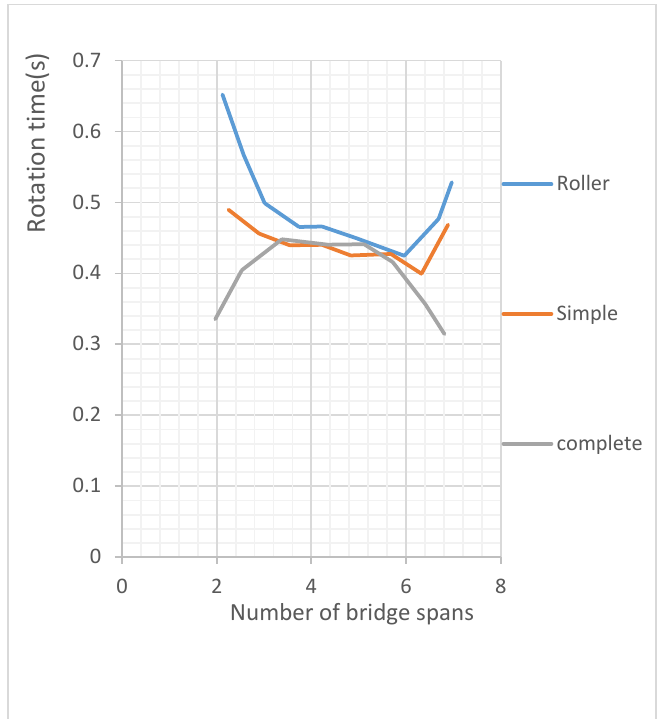
Fig. 13. The fundamental period of transverse vibration in bridges with a base height of 8 m.